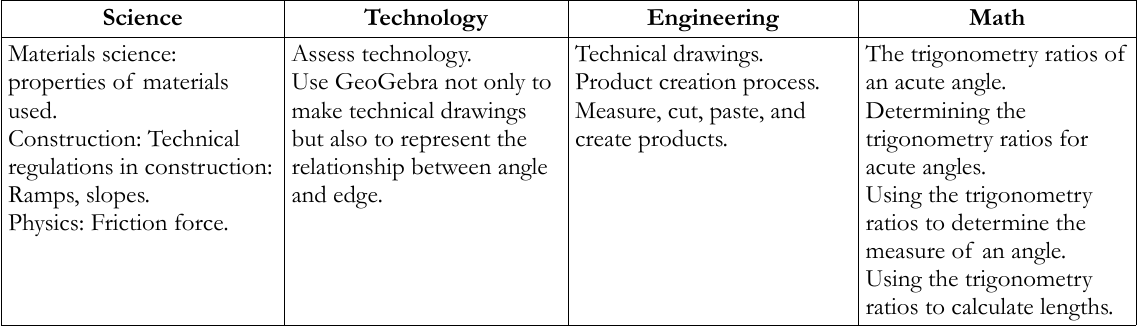
Table 6. The Science, Engineering, Technology, and Math elements that students need to master are used to solve problems